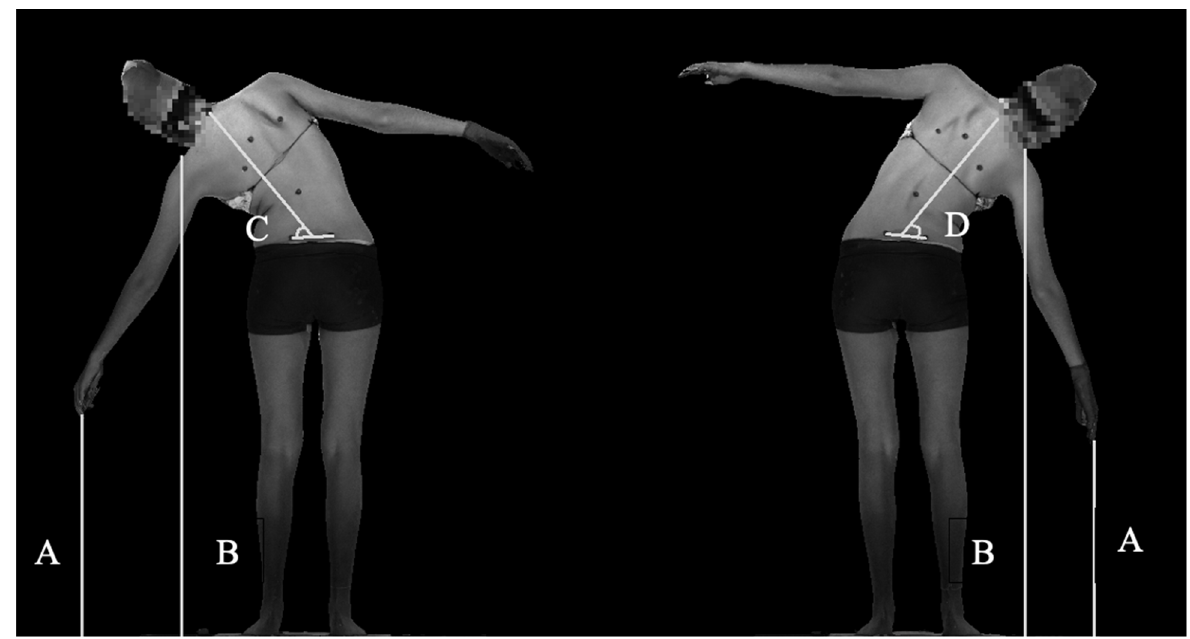
Figure 3. Lateral bending measurements Line A depicts distance from fingertips to floor; line B depicts distance from acromioclavicular joint to floor. Angles C and D represent the left bend coronal angle and right bend coronal angle, respectively.